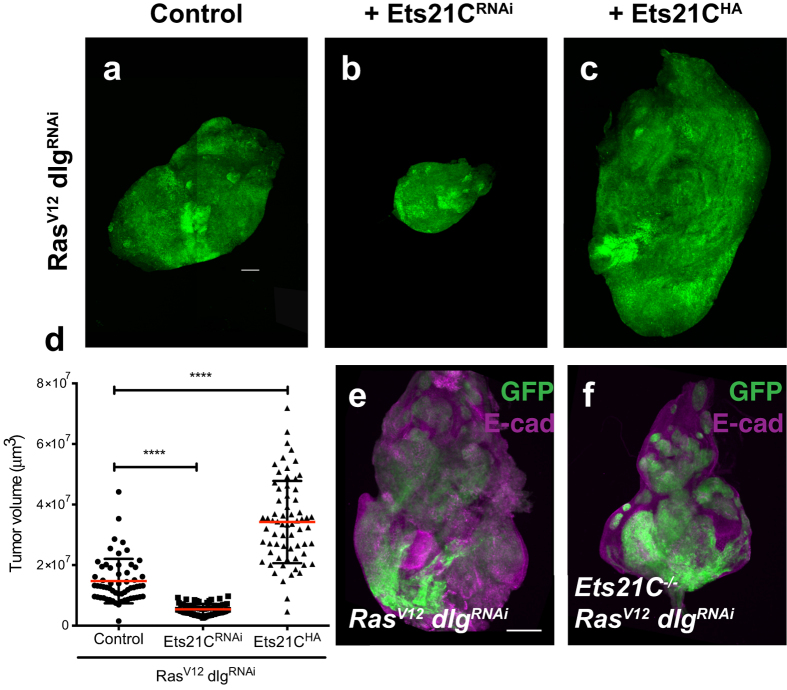
Ets21C is required for RasV12
dlgRNAi tumors.Confocal images of (a–c) imaginal disc tumors expressing different UAS-transgenes under the control of eye specific Gal4: Flp recombinase is driven by the eyeless (ey) promoter, and causes activation of the act > CD2 > Gal4 transgene. Recombined cells are marked by expression of a UAS-GFP transgene (green). The discs co-express the following transgenes: (a) RasV12, dlgRNAi, (b) RasV12, dlgRNAi, Ets21CRNAi, (c) RasV12, dlgRNAi, Ets21CHA. (d) Quantification of tumor volume for the genotypes indicated (Mann-Whitney test ****p < 0.0001). Error bars indicate SD. (a,c) are composites of several images to display the whole tumor size. (e,f) ey-FLP induced MARCM clones34 that are positively labeled with GFP (green). Additionally, discs are stained for E-cadherin (E-cad) to visualize cell outlines (magenta). (e) RasV12
dlgRNAi expressed in wild-type clones, (f) RasV12
dlgRNAi expressed in clones homozygous mutant for Ets21C. Scale bar: 100 μm.